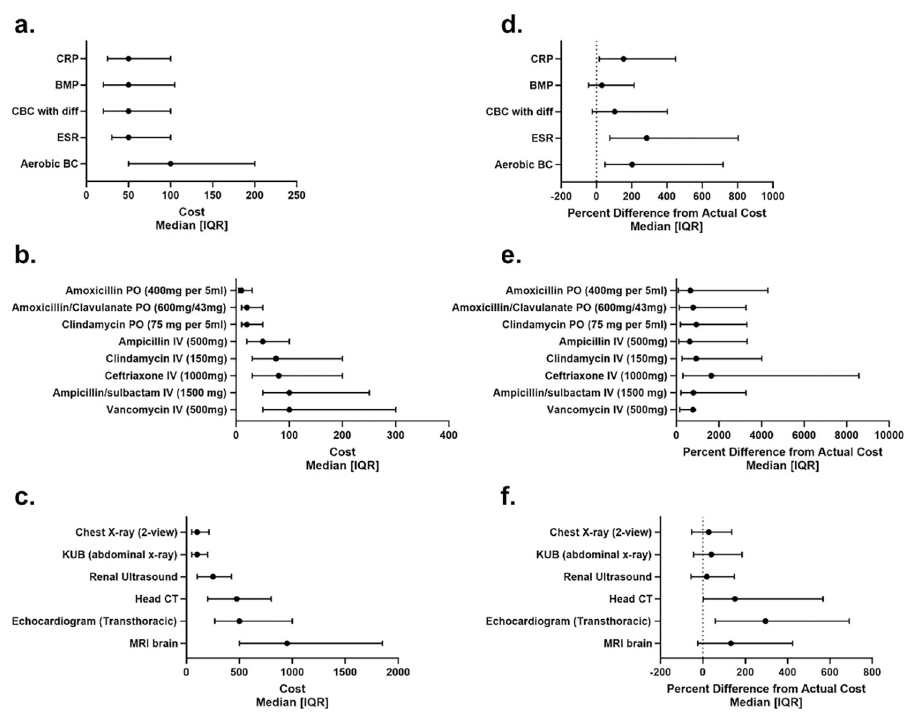
Fig 1. Median hospital-specific cost (1a-1c) and percent [interquartile] difference of respondent estimates from hospital cost of commonly ordered items (1d-1f). CRP = C-reactive protein, BMP = Basic metabolic profile, CBC = Complete blood count, ESR = Erythrocyte sedimentation rate, BC = Blood culture, PO = Oral, IV = Intravenous, mg = milligram, ml = milliliter, CT = Computer tomography, MRI = Magnetic resonance